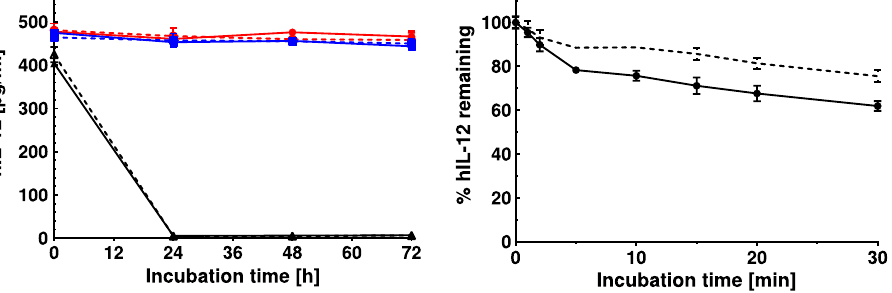
Figure 2. Effect of heparin on proteolytic degradation of hIL-12. ( a ) hIL-12 degradation when incubated with (open symbols) and without heparin (closed symbols) in spent media (squares), fresh AMEM containing BSA (circles) or fresh AMEM containing 0.125% trypsin (triangles). Samples were collected at intervals of 0, 24, 48 and 72 hours and hIL-12 concentrations were quantified via ELISA. Heparin did not affect hIL-12 degradation (p > 0.05 vs. hIL-12 alone via two-way ANOVA). ( b ) hIL-12 degradation when incubated with (open circles) and without heparin (filled circles) in protease cocktail containing trypsin, chymotrypsin, thrombin and thermolysin. Proteases were added to hIL-12 solution at a protein to protease molar ratio of 10:1. Samples were collected and neutralized with protease inhibitor cocktail at intervals of 0, 1, 2, 5, 10, 15, 20 and 30 min and hIL- 12 concentrations were quantified via ELISA. Heparin significantly inhibited hIL-12 degradation by protease cocktails. Asterisks indicate a significant difference between groups at a particular time point ( * = p < 0.01 vs. hIL-12 alone via t-test). All data are represented as mean ± standard deviation from triplicate samples. All experiments were repeated at least twice with similar results.